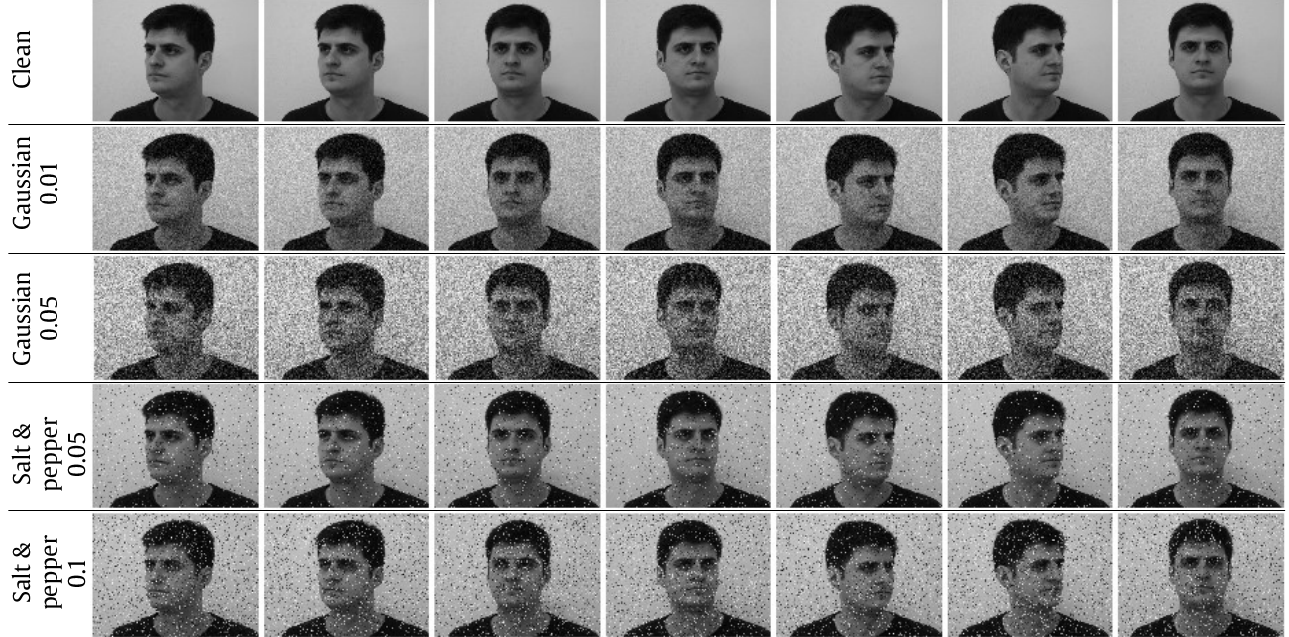
Figure 7. Samples of FEI database with different